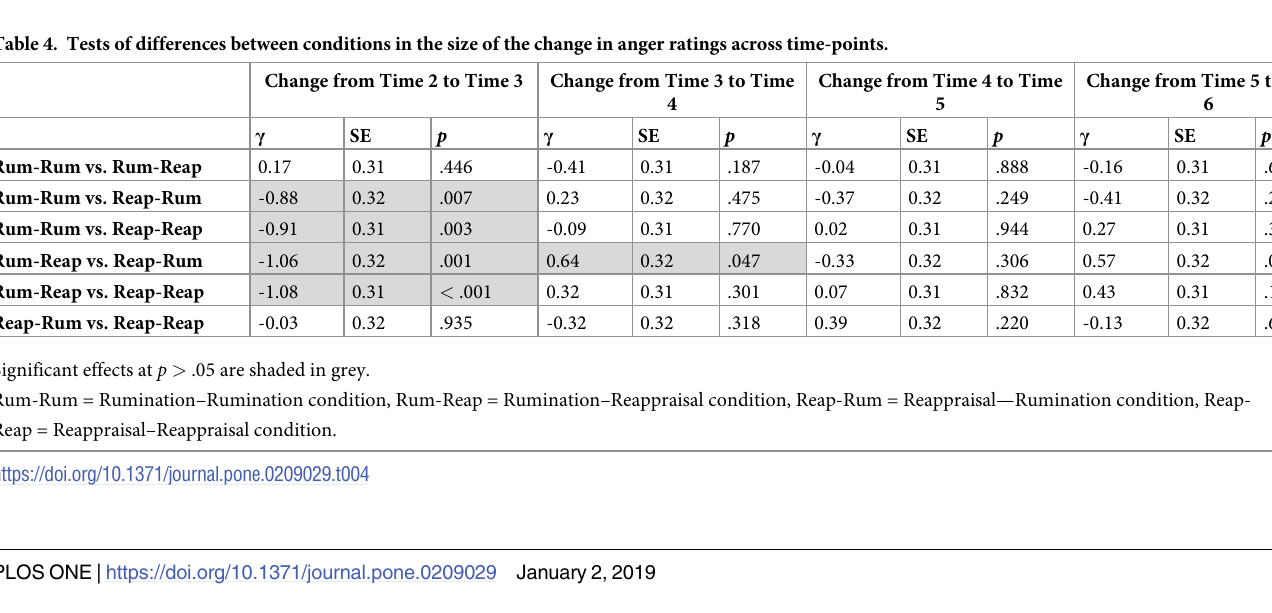
Change from Time 4 to Time Change from Time 5 to Time 4 5